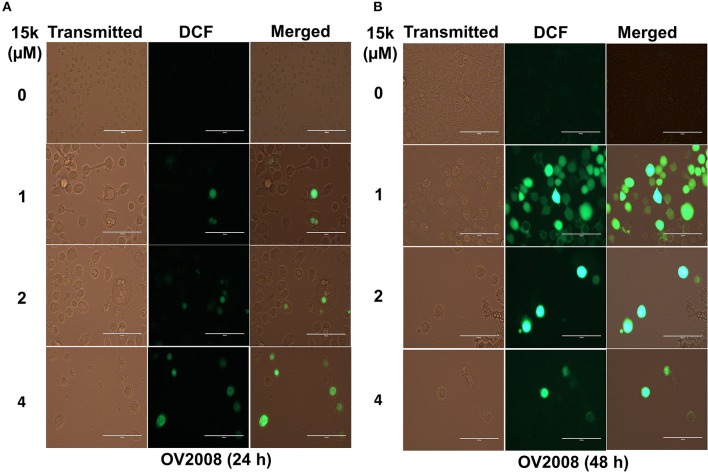
15k induces the generation of ROS in OV2008 cells; (A,B) Representative images of the DCF levels of fluorescence after incubation with 1, 2, and 4 μM of 15k for 24 and 48 h compared to control, respectively. The experiments were repeated in triplicate.